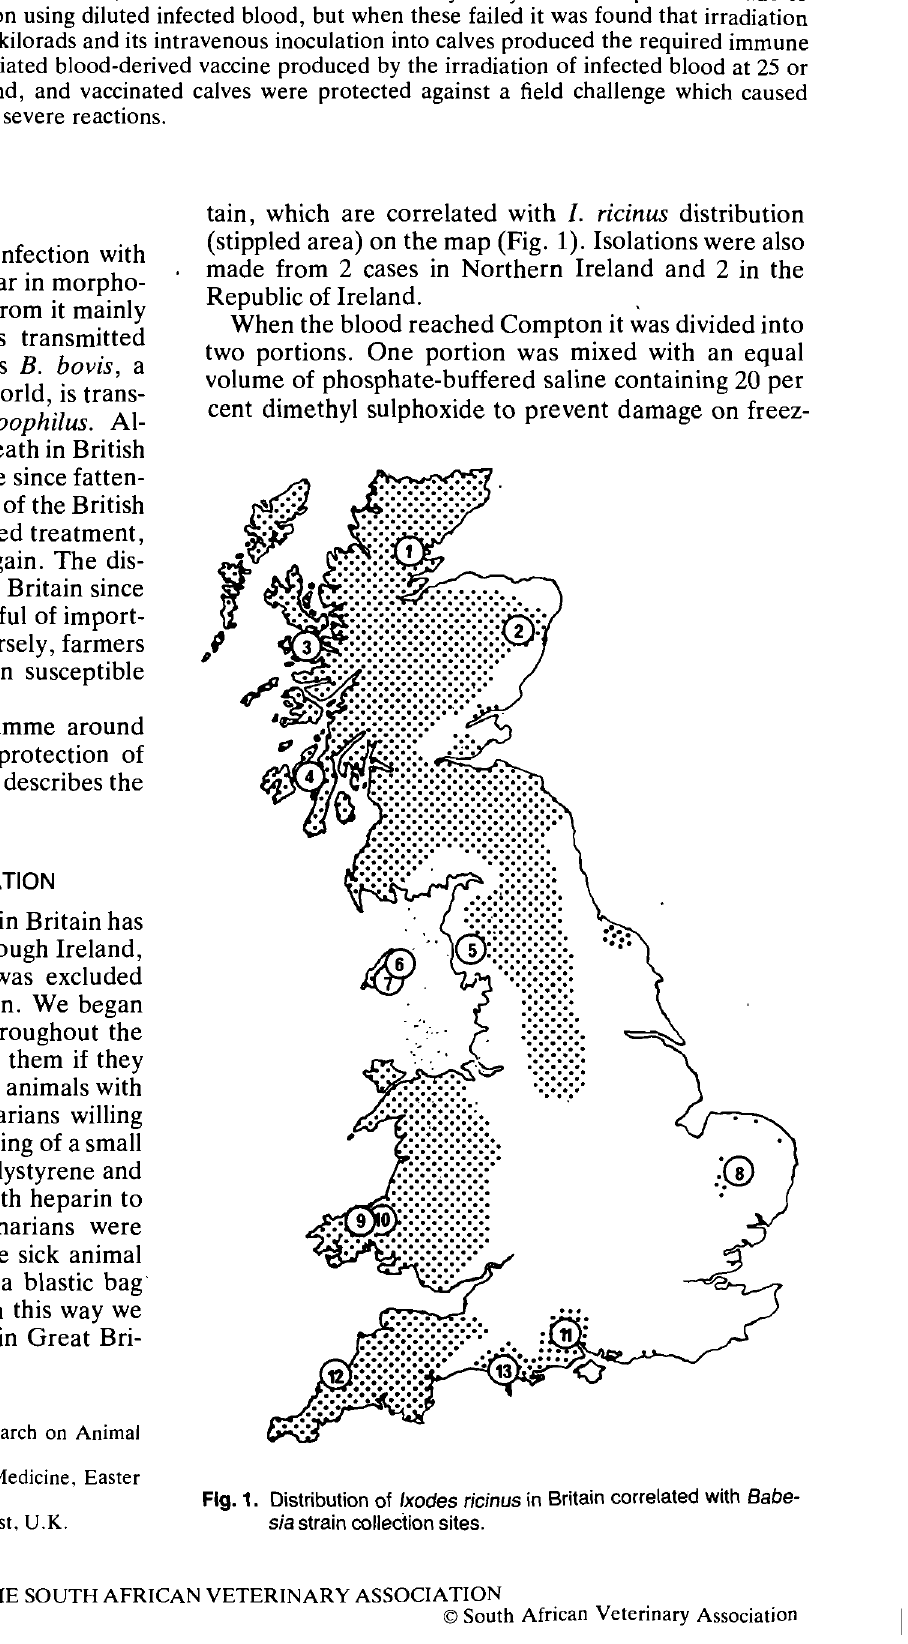
Fig. 1. Distribution of Ixodes ricinus in Britain correlated with Babe sia strain collection